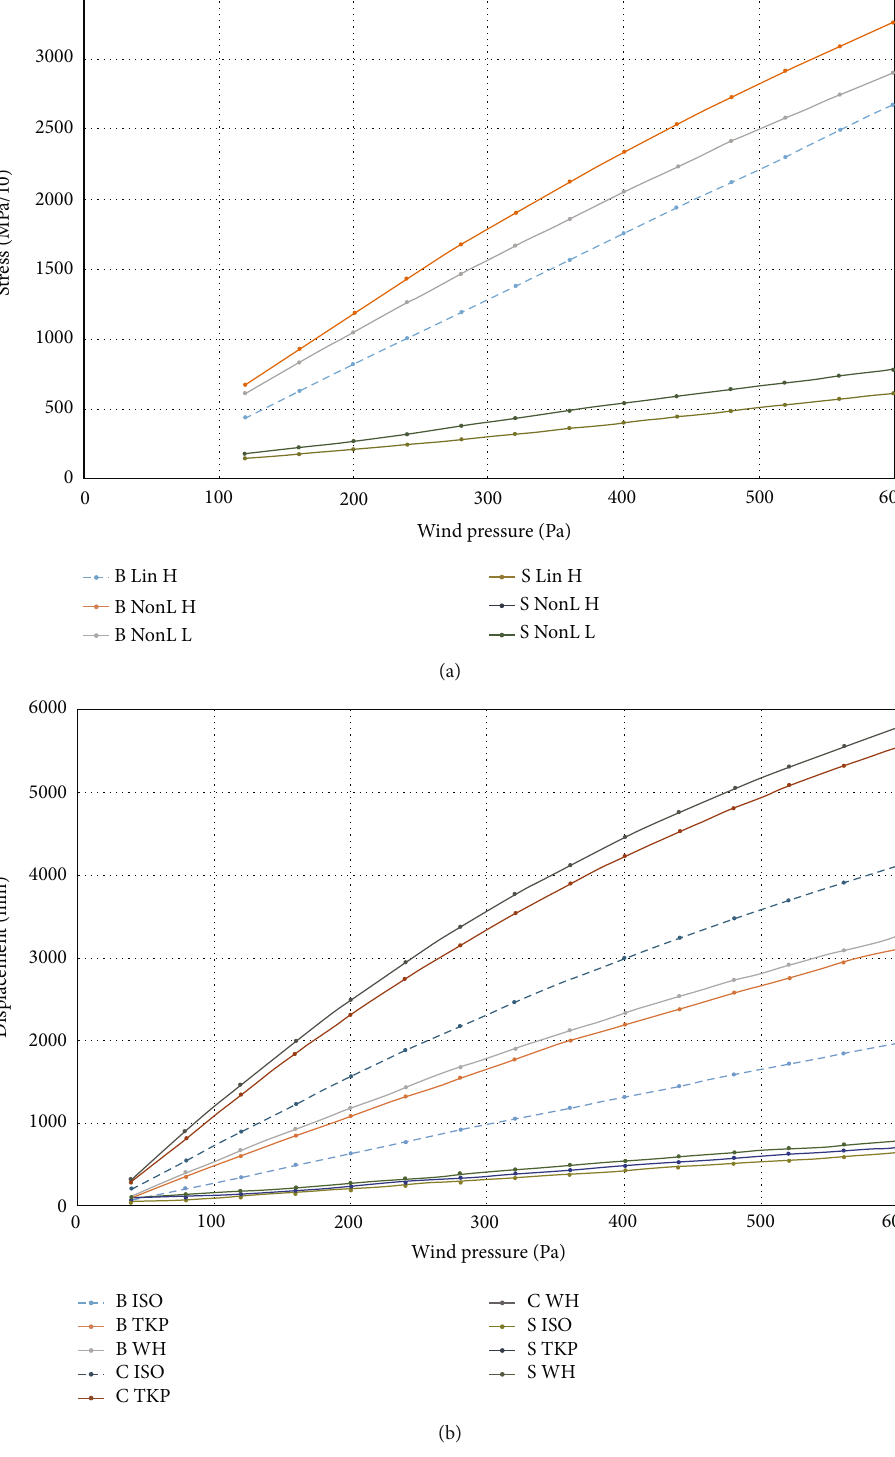
Figure 8: Curves of “ along-wind ” crown top displacement (mm) (mark “ C ” in the curve name), branch top displacement (mark “ B ” ), and maximal equivalent stress on the branch surface ( 10 − 1 MPa, mark “ S ” ): (a) linear ( “ Lin ” ) and nonlinear ( “ NonL ” ) loading for the heavy ( “ H ” ) crown (means H-leaves) and for the light ( “ L ” ) one (means L-leaves) in the case of ChestWH material; (b) nonlinear tree loading for materials ChestISO, ChestTKP, and ChestWH (marks “ ISO, ” “ TKP, ” and “ WH ” , respectively); H-leaves: